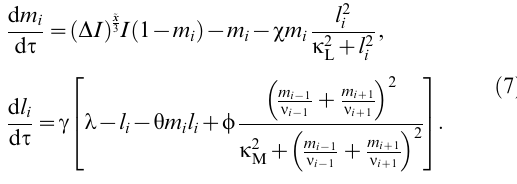
Figure 2C. Calculating the Parameter Space Occupancy